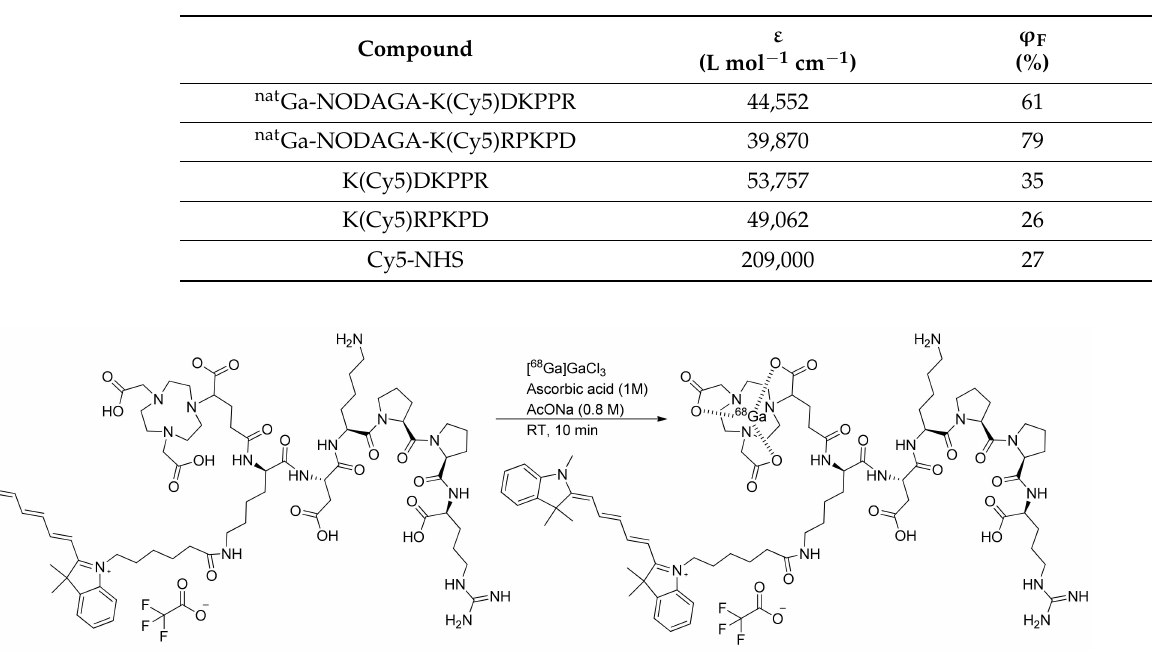
Figure 4. Radiosynthesis of [ 68